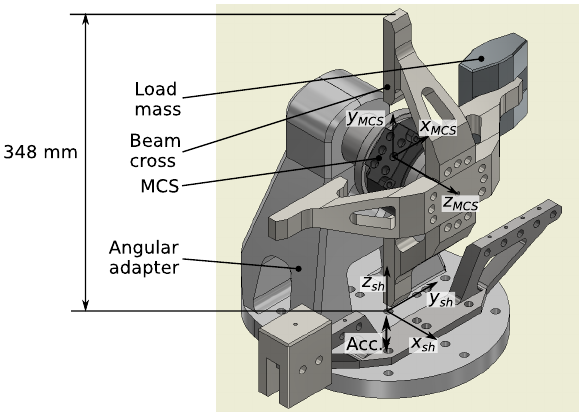
Figure 3. Beam cross for generation of moment